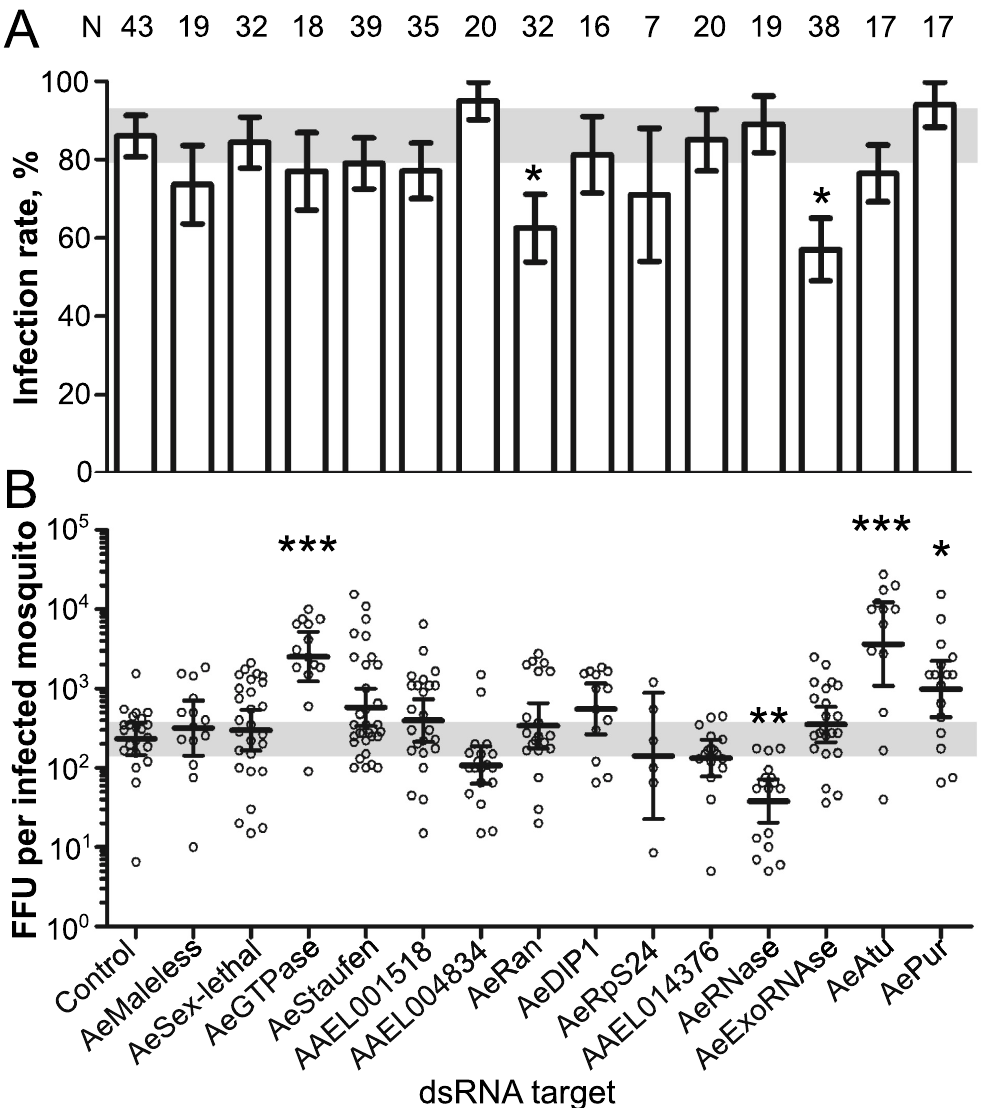
Fig 3. Effects of the 3’UTR-bound proteins on DENV infection in mosquitoes. Four days post-dsRNA injection to silence each of the 14 3’UTR-bound proteins, mosquitoes were orally infected with 10 6 pfu/ml of DENV2. Infection was quantified 7 days later using focus forming unit (FFU) assay. (A) Infection rate. Bars show percentage ± s.e. � , p-value < 0.05 as determined by Z-test. (B) FFU per infected mosquito. Bars show geometric means ± 95% C.I. � , p-value < 0.05; ��� , p- value < 0.001 as determined by Dunnett’s test compared to control mosquitoes injected with dsRNA control. N, number of orally-infected mosquitoes. Data from three biological repeats, each using a specific set of dsRNA targets, were combined. DsRNA control was included in each